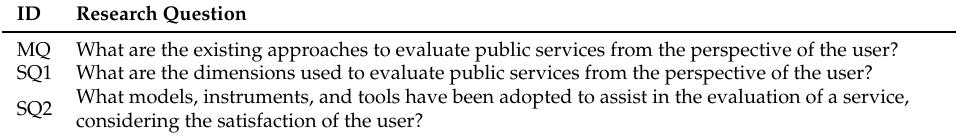
Table 1. Research